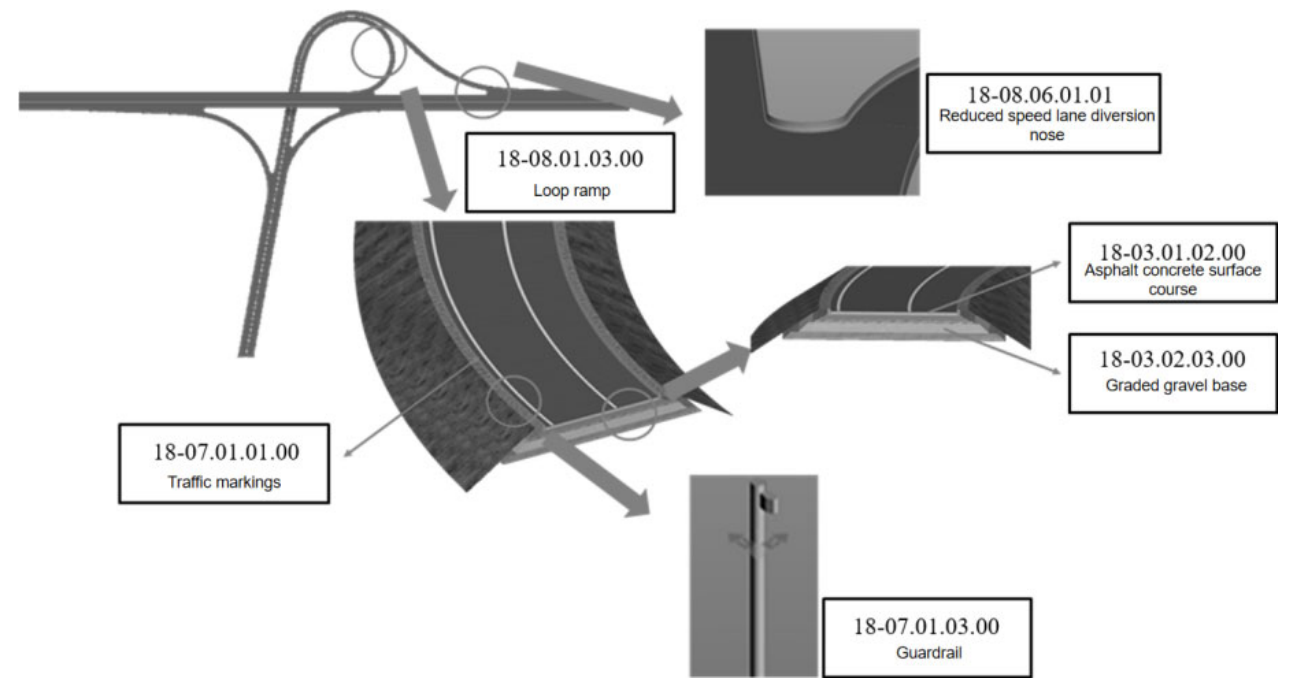
Figure 5. Design results using the BIM components library. Table 10. Quantities of interchange BIM components.